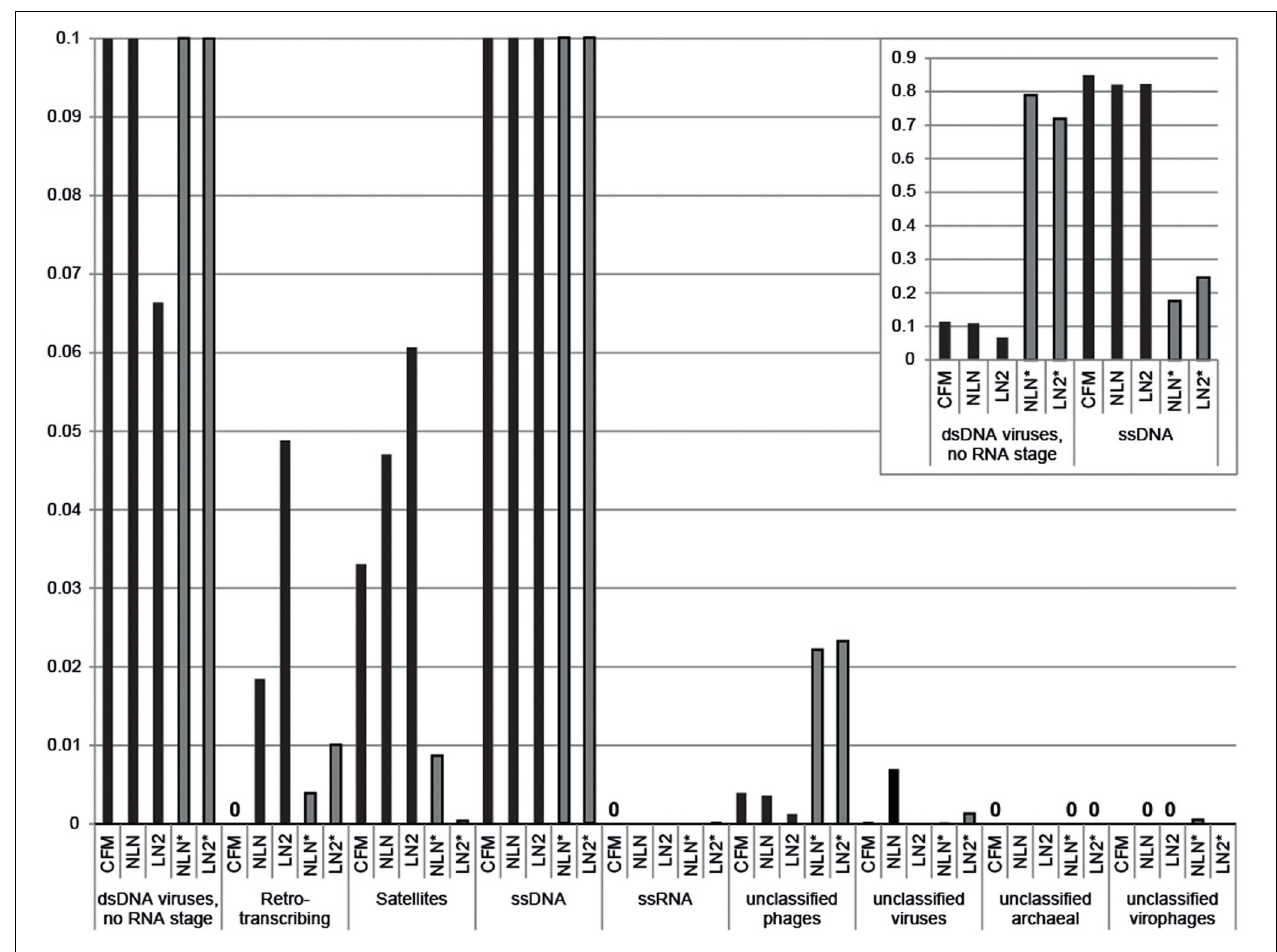
FIGURE 3 | Annotation of Pocillopora damicornis DNA virome metagenomic sequences with a match to viral sequences for each method and treatment. Best matches to major viral groups were examined through Metavir, which uses tBLASTx algorithm against the NCBI viral Refseq genomes with a bit-score of 50 (data sets are publically available at